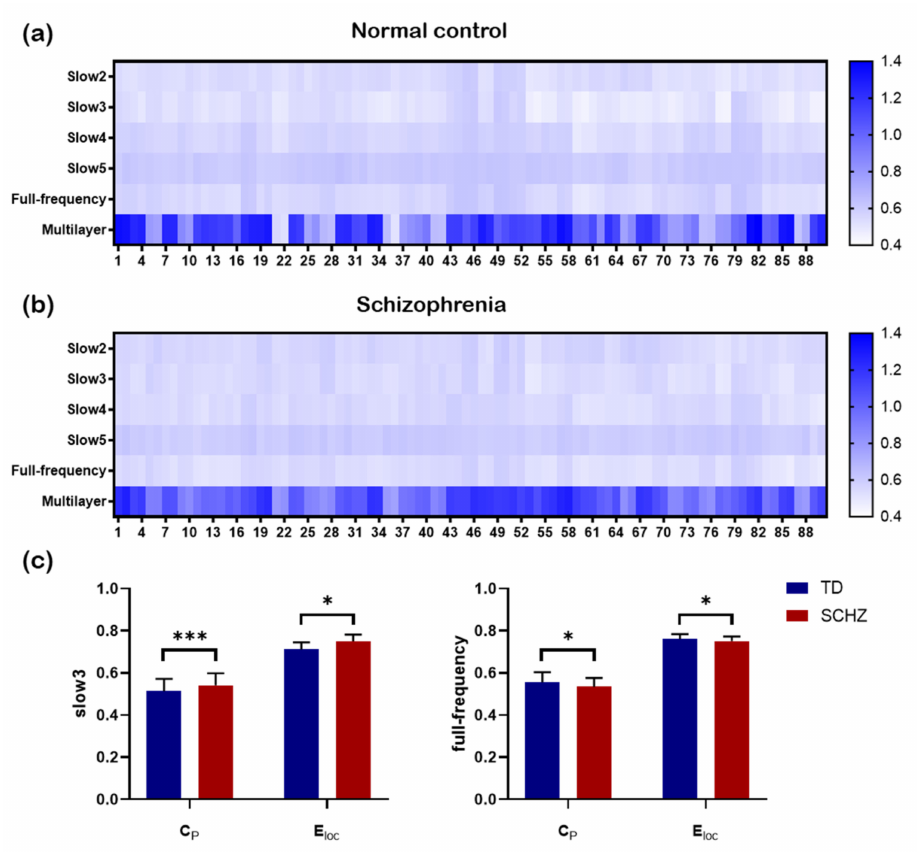
Figure 5. The clustering coefficient values of 90 brain regions. ( a ) The clustering coefficient for each region for four single-layer frequency-specific networks and a multilayer network in the healthy group is shown. ( b ) The clustering coefficient for each region for four single-layer frequency-specific networks and a multilayer network in patients with schizophrenia is depicted. ( c ) The differences in the clustering coefficient (C p ) and local network efficiency (E loc ) between the two groups in the slow3 frequency and full-frequency are shown. * indicates 0.01 < p < 0.05. *** indicates p = 0.000.